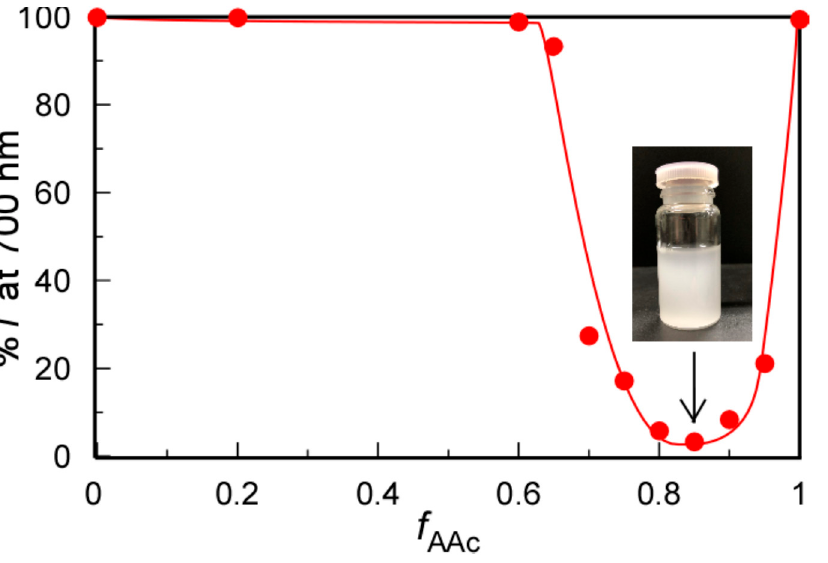
Figure 2. Percent transmittance (% T ) at 700 nm for PMPC/PAAc mixed aqueous solutions as a function of f AAc (= [AAc]/([MPC]+[AAc])) at C p = 0.5 g/L, [NaCl] = 0.1 M, pH = 3, and 20 °C. The insert is a picture of the solution at f AAc = 0.85.